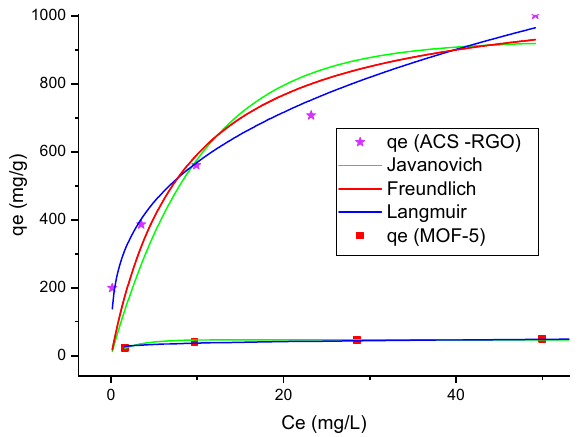
Figure 6. The illustration of isotherm models applied to equilibrium MG removal by ACS-RGO and MOF-5.